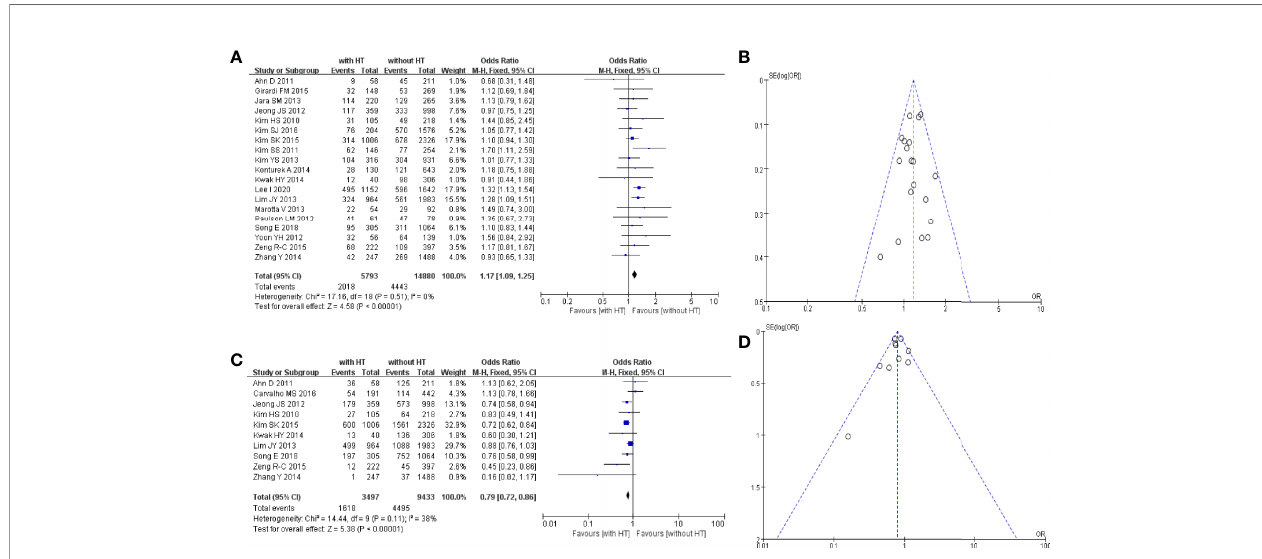
FIGURE 3 | HT and multifocality of PTC patients: (A) forest plot and (B) funnel plot. HT and extrathyroidal extension of PTC patients: (C) forest plot and (D) funnel plot.